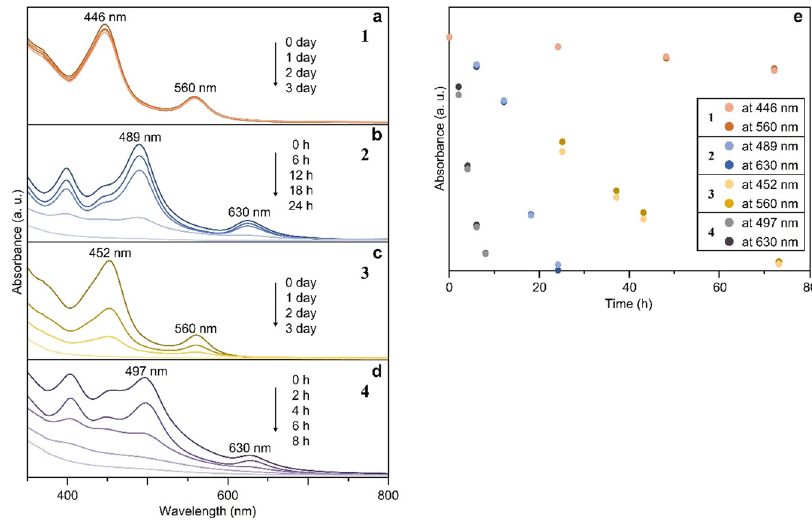
Fig. 7 Time dependence of the optical absorption spectra. a – d are time-dependent optical absorption spectra of 1 , 2 , 3 and 4 , respectively. e Time dependence of plots of absorbance of the fi rst and second peaks in the optical absorption spectra of 1 (446 and 560 nm), 2 (489 and 630 nm), 3 (452 and 560 nm) and 4 (497 and 630 nm) (orange = 1 , dark blue = 2 , yellow = 3 , purple = 4 ). In these spectra, the peak positions are little shifted compared to those in Fig. 4, probably due to the difference in solvent (dichloromethane for Fig. 4 vs. toluene for Fig.